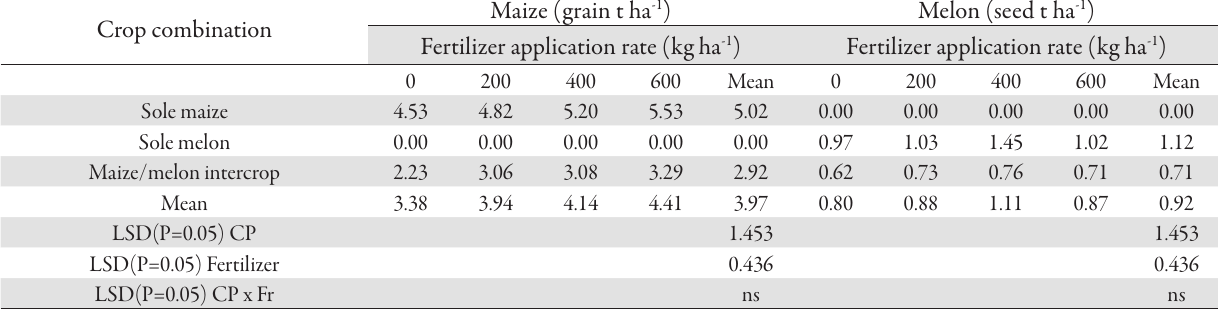
Tab. 3. LER as influenced by intercropping and fertilizer application Cropping